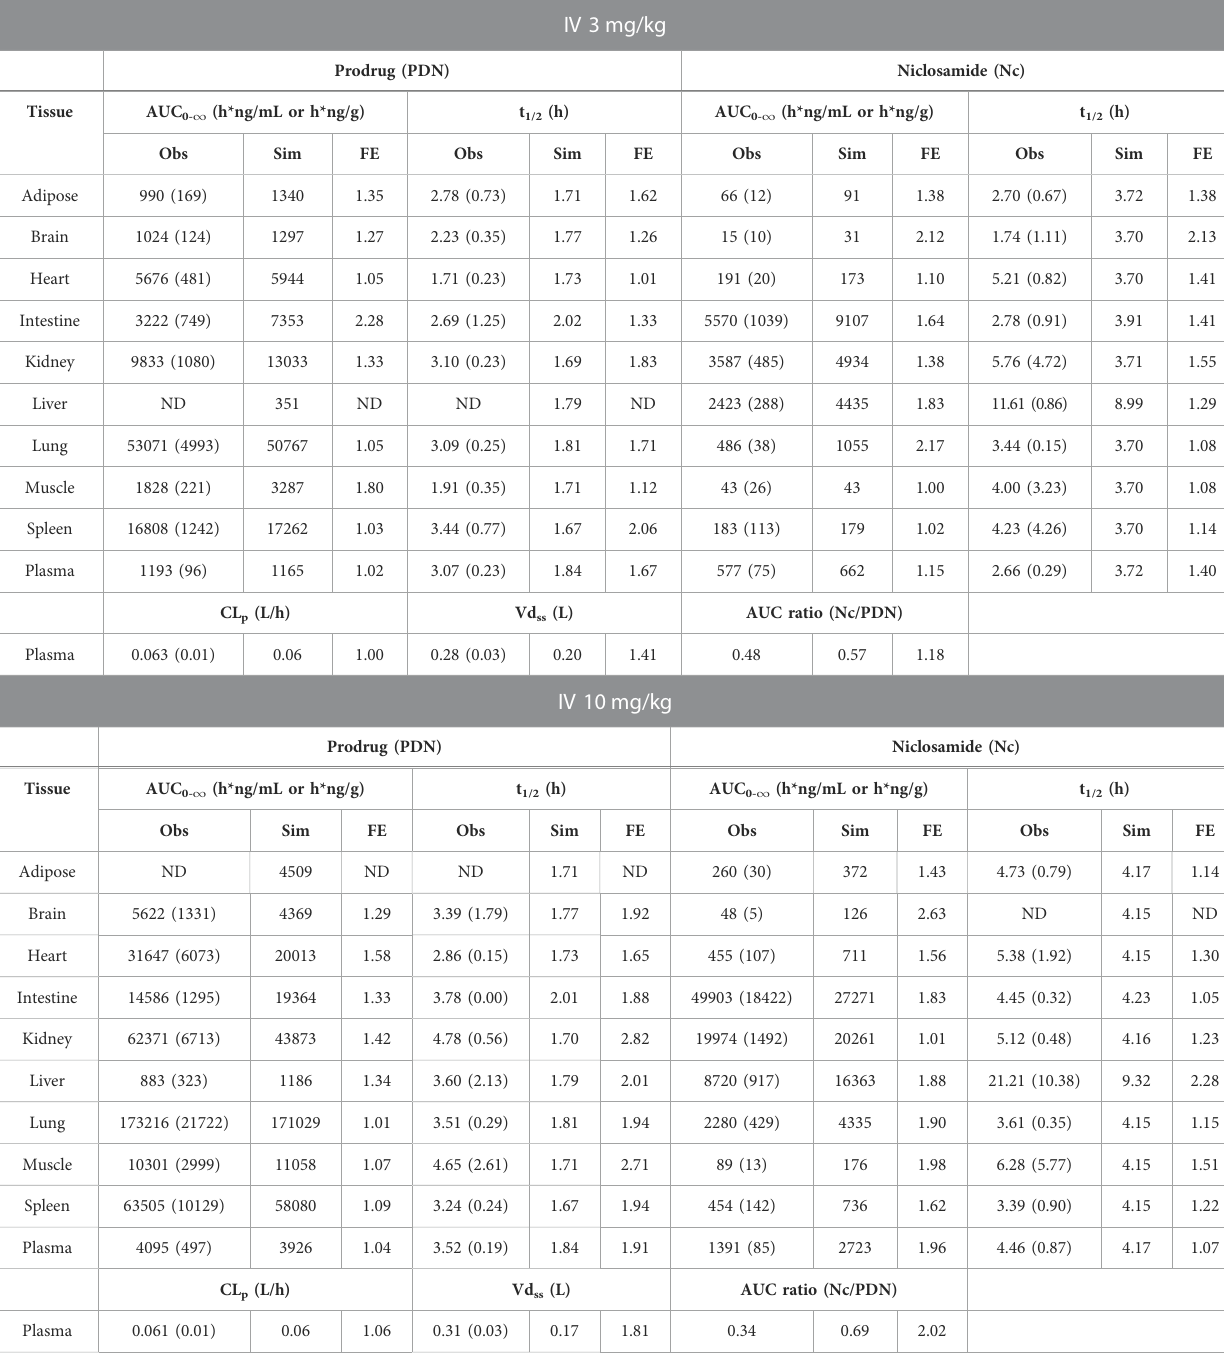
lower than 3% of metabolized PDN was detected to be Nc in mouse and human liver microsomes, while about 10% of PDN was converted to Nc inhamsterlivermicrosomes.Inaddition,PDNwasalsoincubatedinliver cytosolic fractions and the in vitro metabolic half-life (t 1/2 ) was larger than